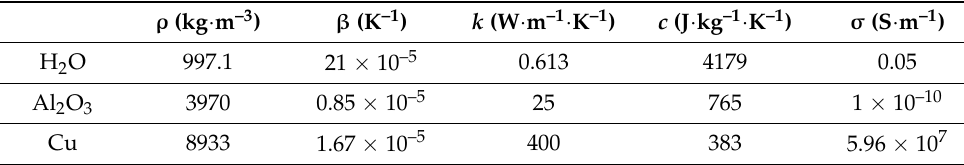
Figure 1. The physical domain of the square cavity. Table 1. Chemical attributes of H 2 O, Al 2 O 3 and Cu [14].